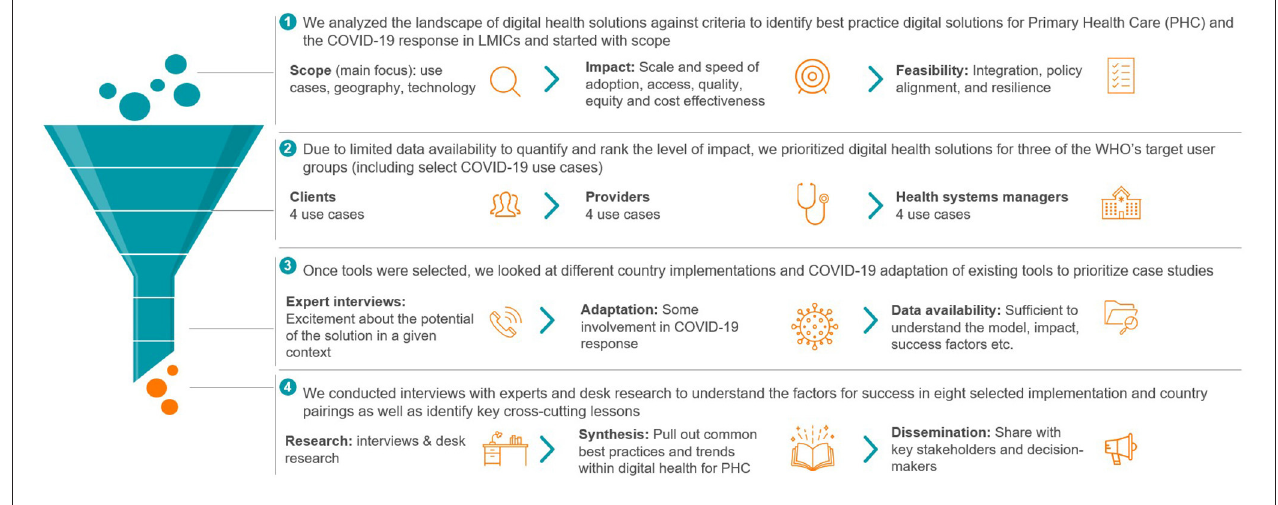
FIGURE 1 | Methodology used to select the digital tools for this